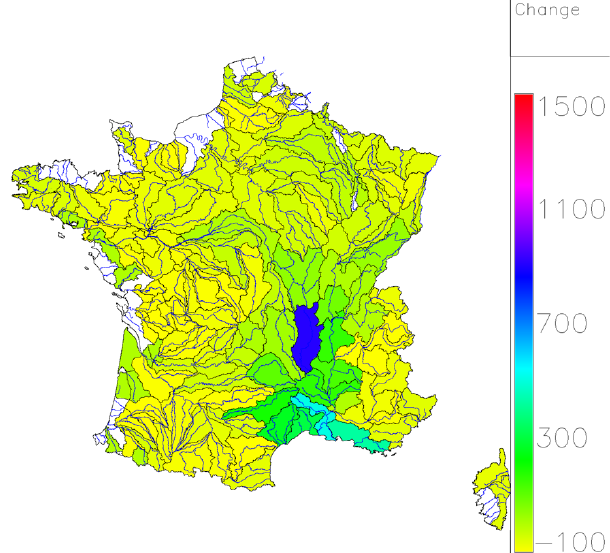
Fig. 6. The color of the areas correspond to changes in flood losses, in percent. The result presented here correspond to QMS scenario, comparing costs in 1970–1999 and 2069–2098; the loss-ratio as- sumption is based on the Var event losses.